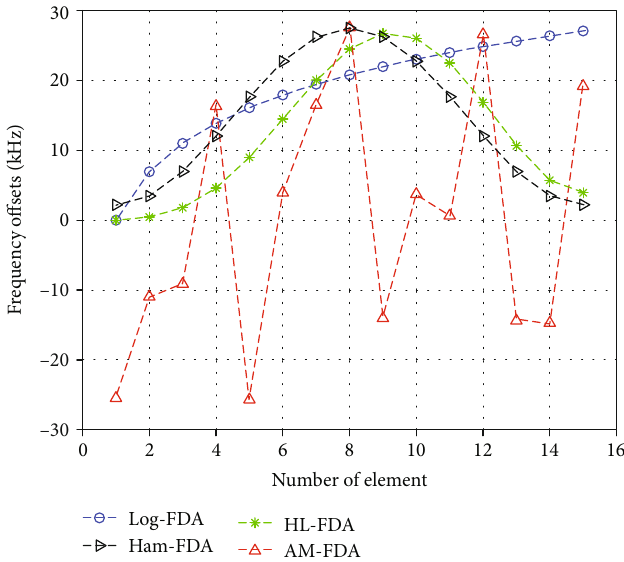
Figure 4: Frequency o ff set